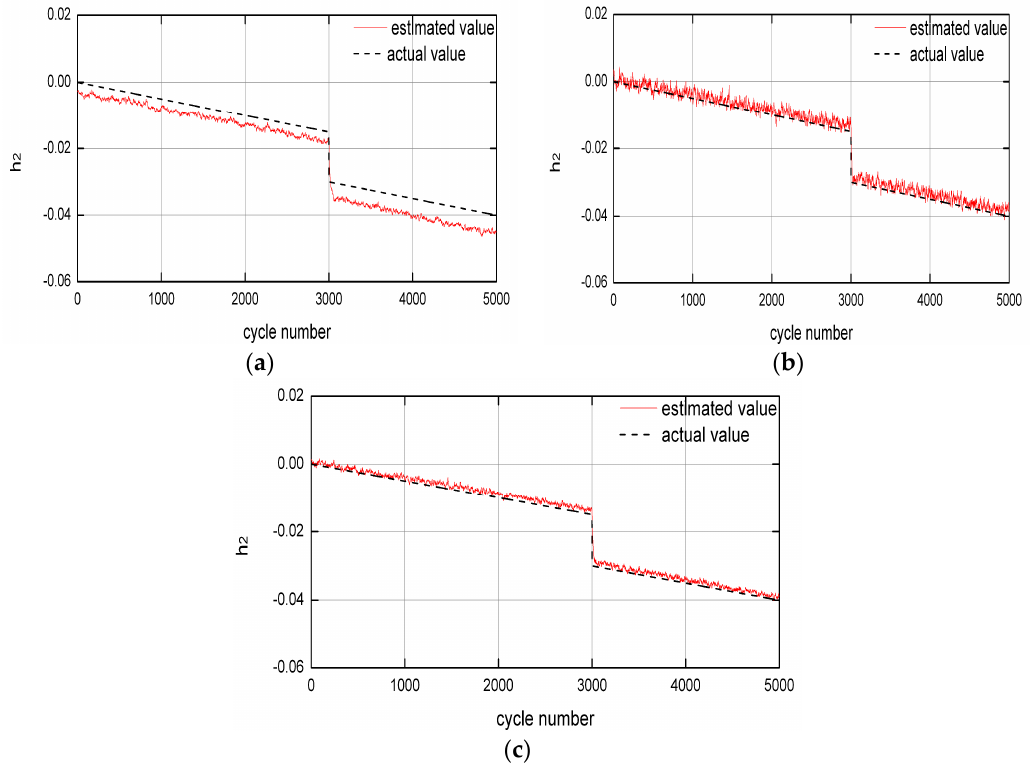
Figure 10. The health estimation corresponding to the injected 4% decrease on ℎ (cid:2870) that is applied over 5000 cycles (Mode 6) in scenarios with uncertainties. ( a ) Results by KF; ( b ) Results by SMO; ( c ) Results by SOSMO. Table 3. The average RMSE and SD corresponding to the injected 4% decrease on ℎ (cid:2870) that is applied Table 3. The average RMSE and SD corresponding to the injected 4% decrease on h 2 that is applied over 5000 cycles (Mode 6) in scenarios with uncertainties. (%) over 5000 cycles (Mode 6) in scenarios with uncertainties.